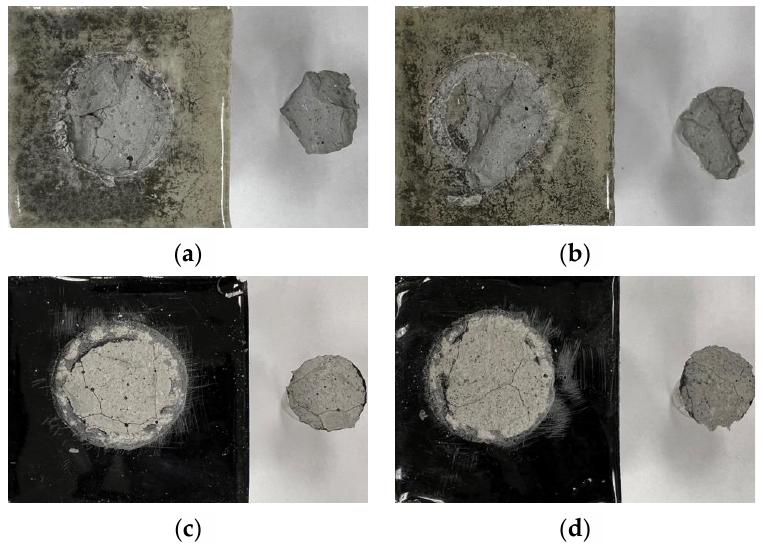
Figure 13. The fractured surface after the adhesion test, ( a ) pure epoxy, ( b ) epoxy with GNP, ( c ) epoxy with NS, and ( d ) epoxy with GNP-NS hybrid fillers.